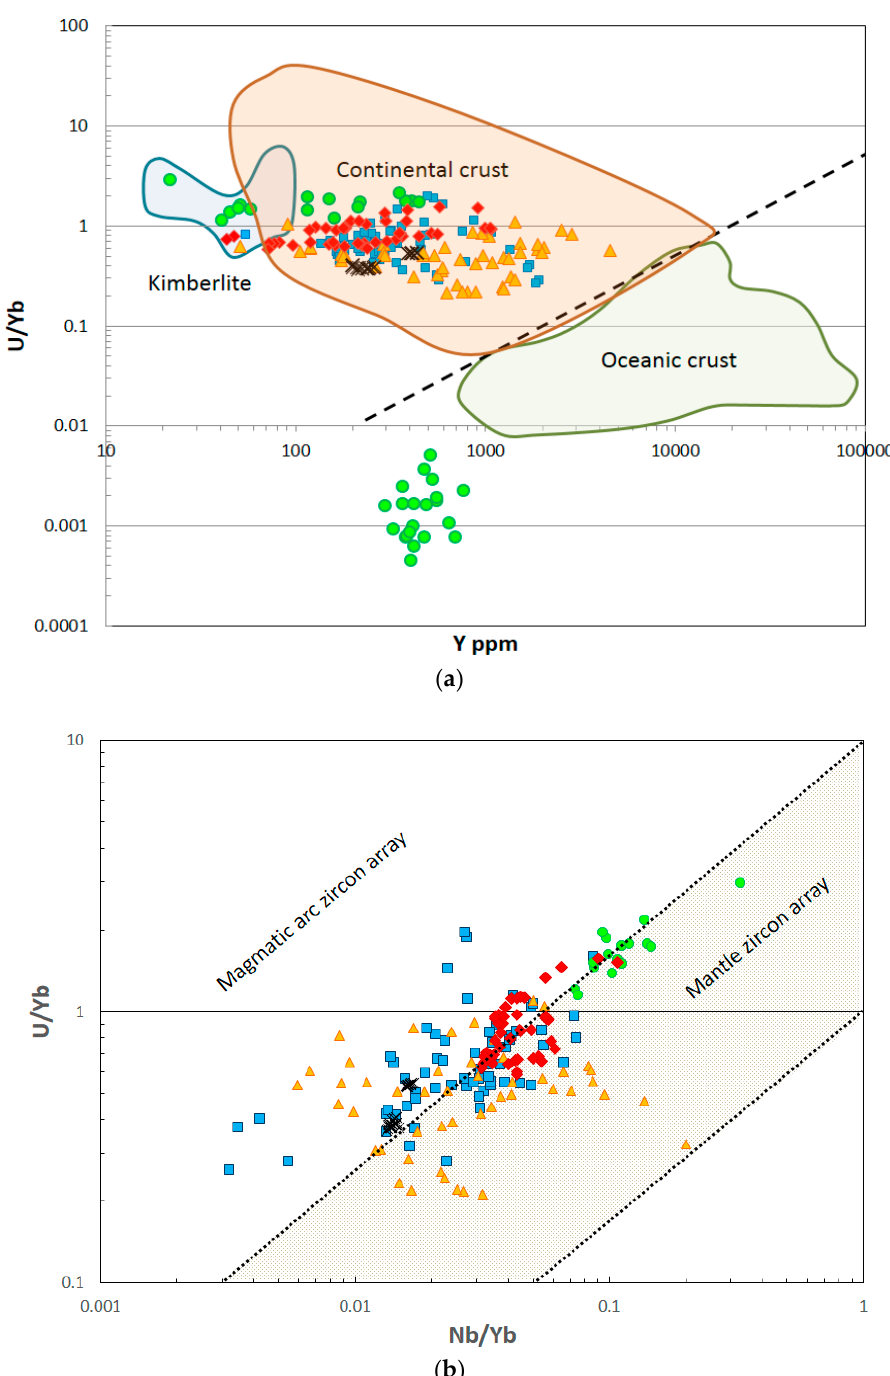
Figure 12. Y versus U/Yb ( a ) and Nb/Yb versus U/Yb. ( b ) Discrimination diagrams for zircon from the RVP (red diamonds, black X’s [23] ), Thailand (blue squares, Piilonen, unpublished data), other ZIP localities (orange triangles, Australia, Laos, Vietnam [11] ), and carbonatites (green circles [5] ). Fields for continental and oceanic crust and kimberlite from Grimes et al. [105] . Fields for mantle and magmatic arc arrays from Grimes et al . [106] .